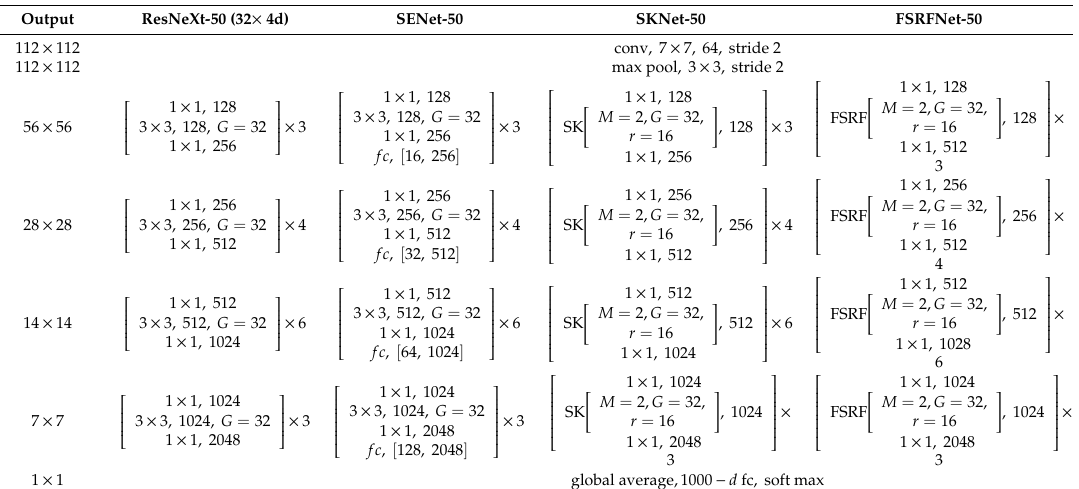
Table 1. Network architecture based on the ResNeXt-50